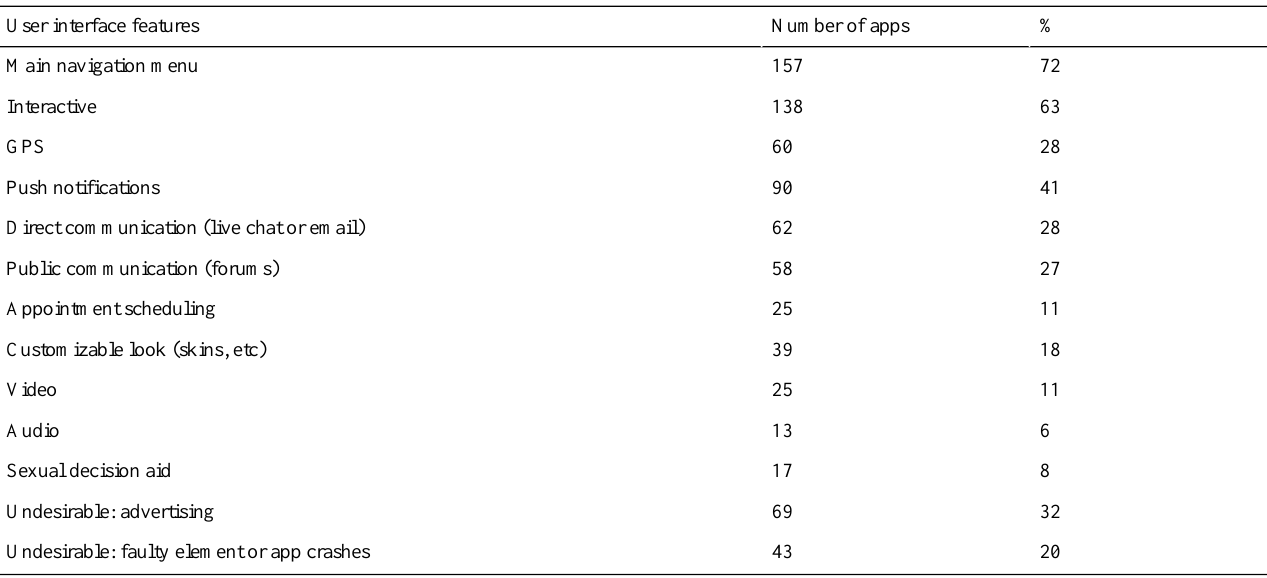
Table 3. Key user interface